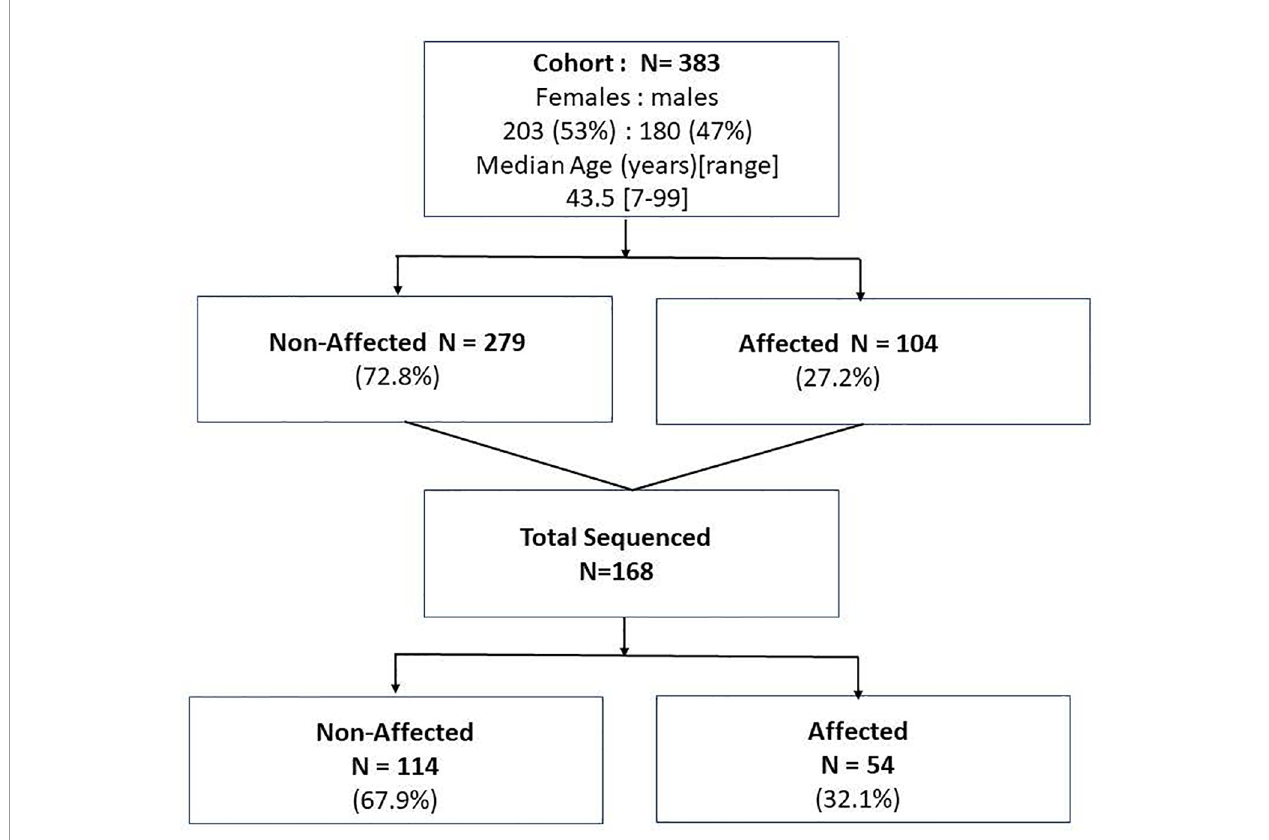
FIGURE 1 | The study population of the affected and non-affected by FNMTC participants that underwent clinical evaluation and subjects who in addition to clinical evaluation underwent whole exome sequencing of the blood/saliva